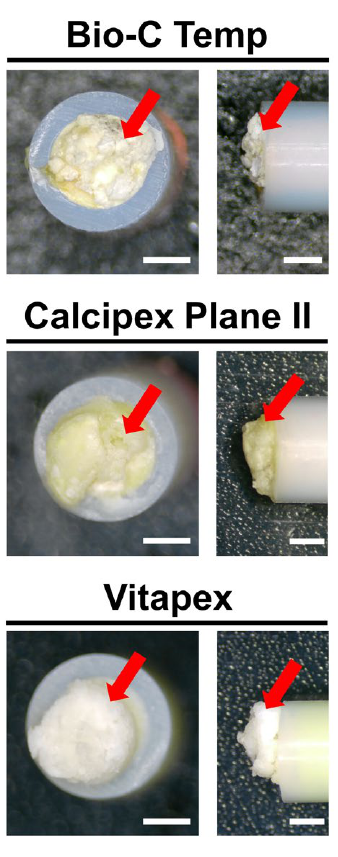
Figure 1. Stereomicroscopic images of the Bio-C Temp, Calcipex Plane II, and Vitapex implants retrieved from rat subcutaneous tissue 28 days after implantation. White precipitates can be observed on the tube openings (arrows). Scale = 1